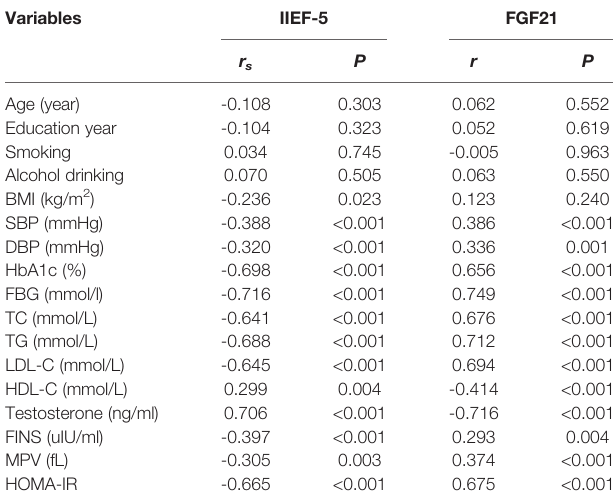
TABLE 2 | Correlation analysis on serum FGF21 level and IIEF-5 score in human study.